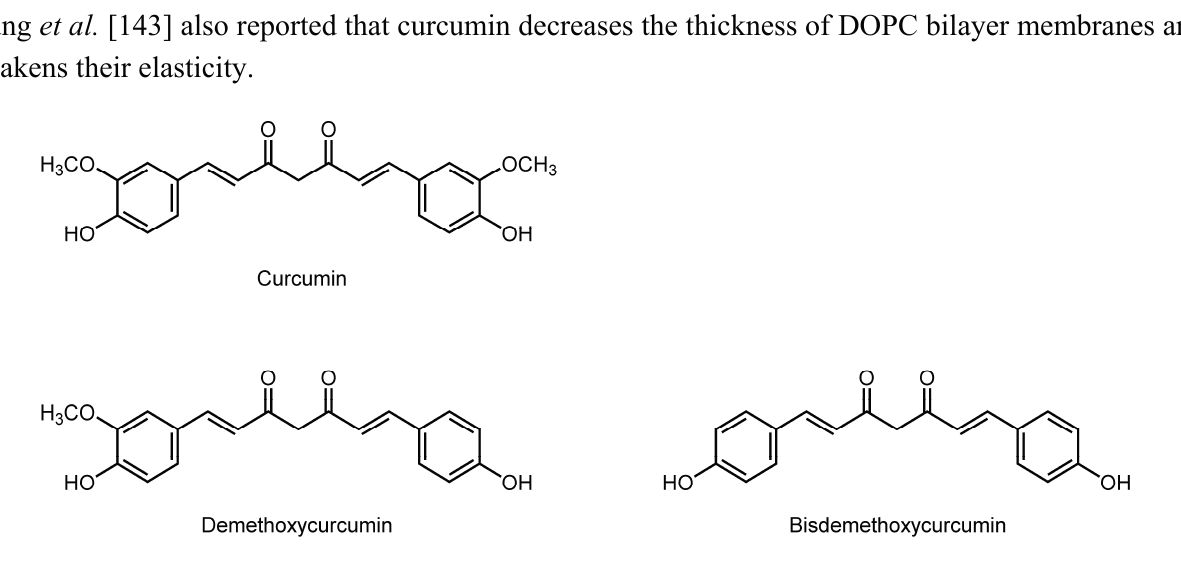
Figure 11. Structures of membrane-interactive